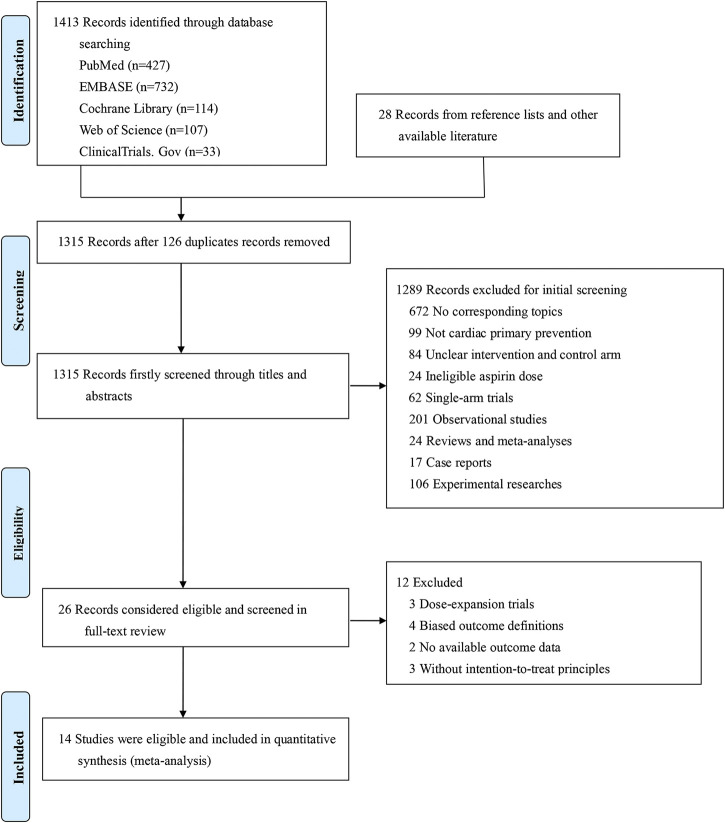
Flow chart for literature search.